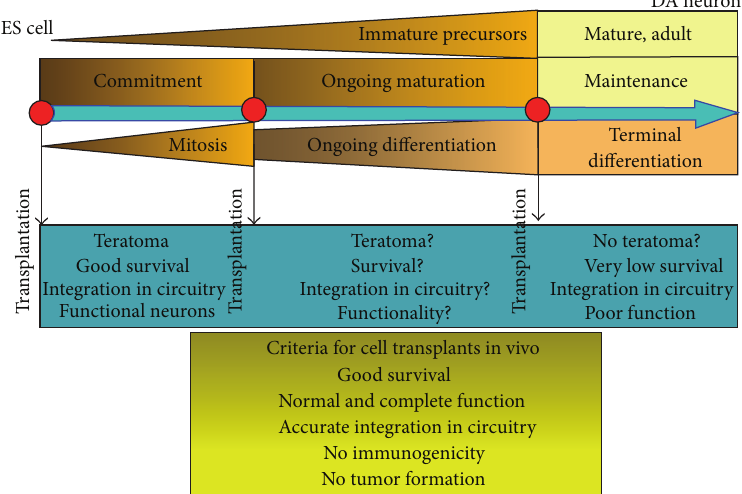
Figure 2: ES cell-derived DA neurogenesis and its implication for transplantation. In vitro and in vivo differentiated ES cells differentiate into immature neural precursors, which develop into mature adult DA neurons. During cell development, three major phases take place: commitmentintotheneuroectodermalcelllineage,maturationintotheDA-specificneuronalphenotype,andmaintenanceofcellfunction.In these phases, the developed cells are either mitotic, for example, ES and lineage-committed immature precursors or terminally differentiated immature or mature DA neurons. For transplantation purposes, it is critical to determine the optimal state of the transplanted cells. For example, it has been shown that transplantation of ES cells in the brain showed good survival and differentiation into functional DA neurons with integration in the brain circuitry but partially developed into teratomas. Some of these observations have also been made by transplantation of immature precursors (unpublished observations). In contrast, transplantation of fully differentiated mature DA neurons did not reveal teratoma formation, but, poor survival and suboptimal function in the brain. These results demonstrate that certain criteria for a DA graft need to be fulfilled in order to achieve optimal results in future ES cell-based transplantation paradigms for PD, which can be summarized as follows: good survival, proper function, and integration into the brain circuitry with no immunogenicity and tumor formation (from